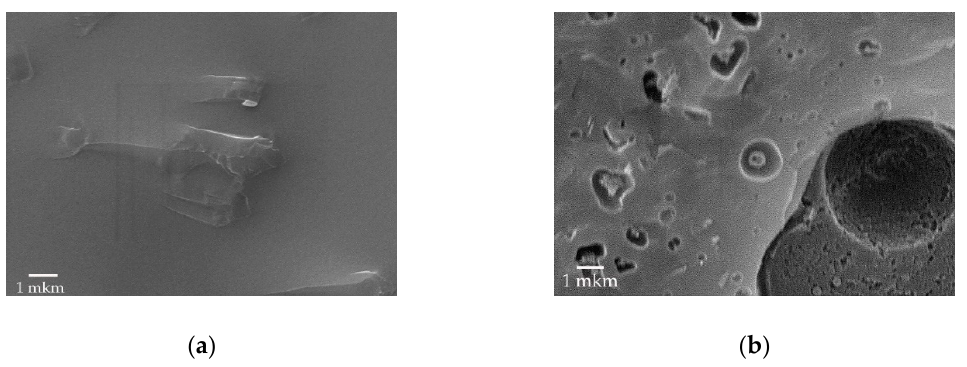
Figure 13. SEM images of transparent ( a ) and opaque ( b ) YAB-based glass–ceramics.